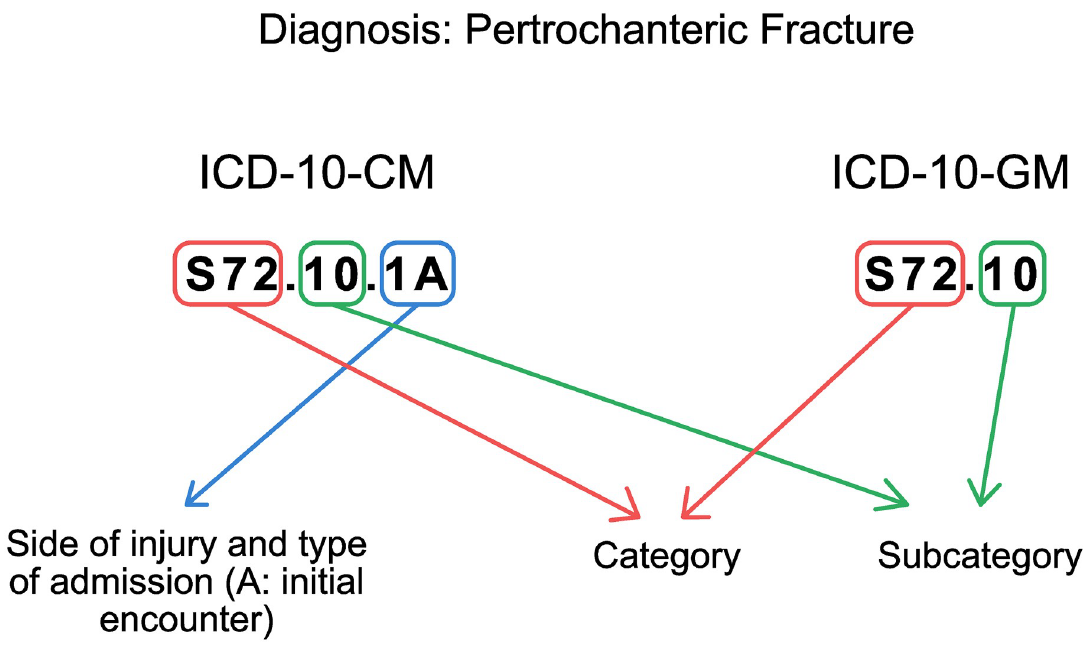
Fig 1. Visualisation of the differences between the ICD-10-CM and the ICD-10-GM coding system based on a pertrochanteric fracture example. ICD-10-CM = Clinical modification of the International Statistical Classification of Diseases and Related Health Problems, 10th revision. ICD-10-GM = German modification of the International Statistical Classification of Diseases and Related Health Problems, 10th revision.